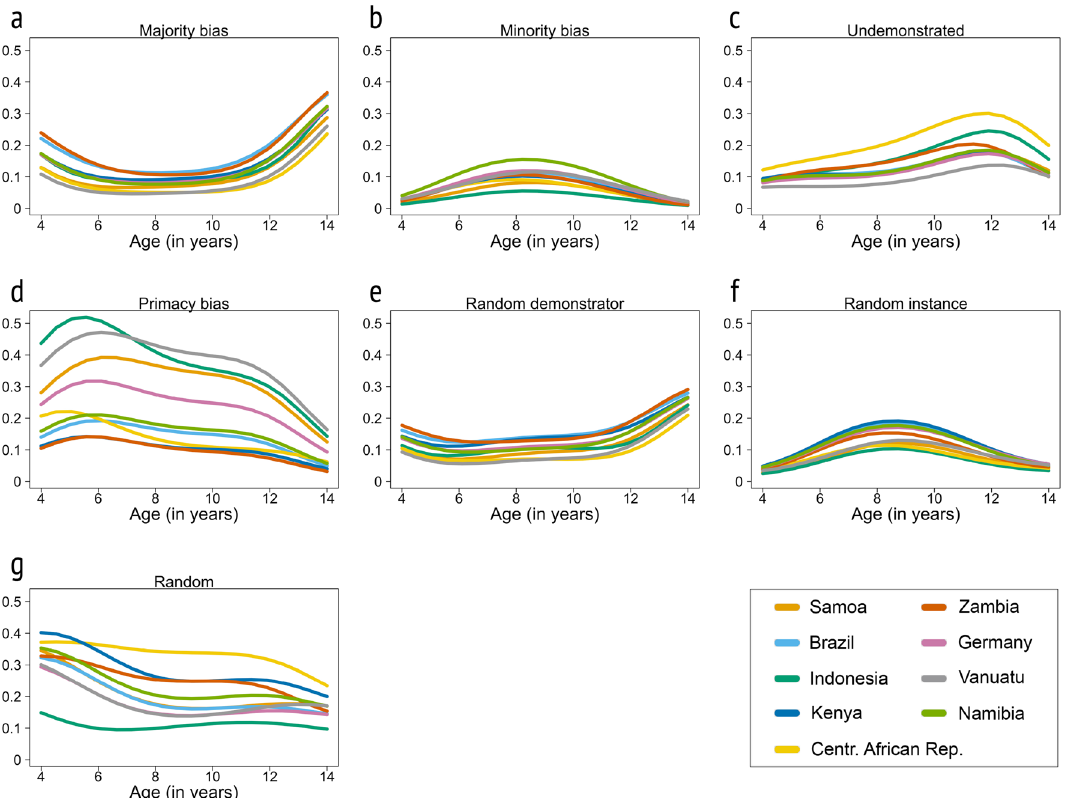
Figure 6. Age patterns of the seven inferred learning strategies by society and across age based on posterior distributions inferred of a Bayesian trinomial-outcome model. The majority bias ( a ) and the random demonstrator strategy ( e ) follow a U-shaped age pattern, while the minority bias ( b ) and random instance strategy ( f ) follow an inverted U-shaped age pattern. The strategy to use the undemonstrated option increases over age before it declines ( c ), the primacy bias decreases (d). Throughout the investigated ages, some data remain randomly distributed ( g